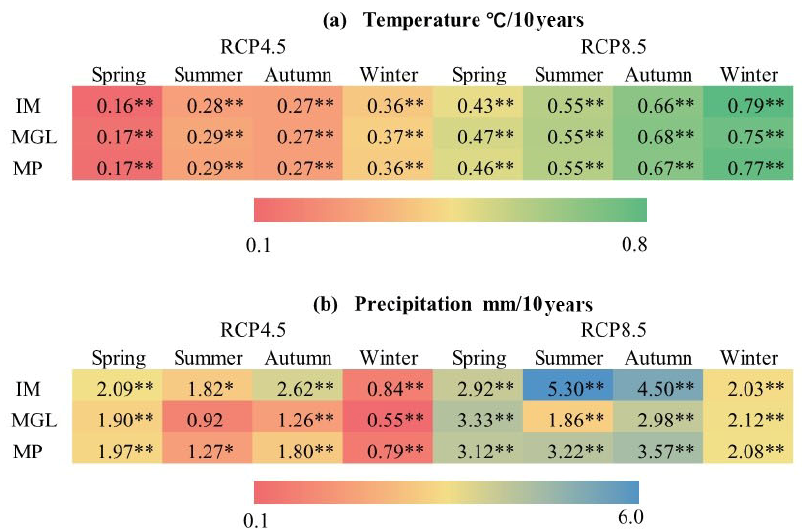
Figure 4. Changes in seasonal ( a ) temperature and ( b ) precipitation during 2020–2100 in Inner Mongolia (IM), Mongolia (MGL) and the Mongolian Plateau (MP) under the representative concentration pathway RCP4.5 and RCP8.5 greenhouse gas emission scenarios; ** and * indicate the trends are significant at the 1% and 95% confidence level,